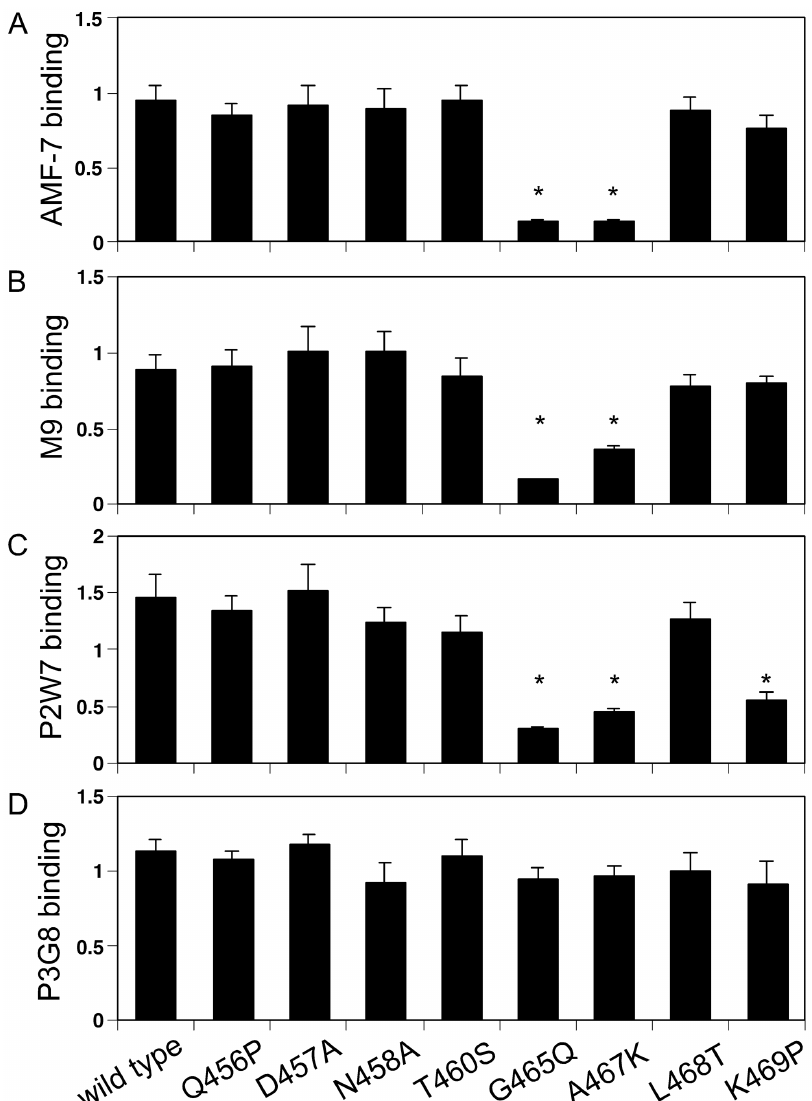
Figure 3. Effect of a V-to- a IIb mutation on the binding of the leg-binding mAbs. The amino acid residues 457–467 of the a V chain were individually mutated to the corresponding a IIb residues. The mutant a V was transiently expressed together with wild-type b 3 in CHO cells, and the binding of mAbs to these cells was examined by FACS. The ratio of the MFI obtained from the whole cell population with each mAb to that obtained with 7E3 is shown as normalized binding. Asterisks indicate binding that was less than 50% of the wild